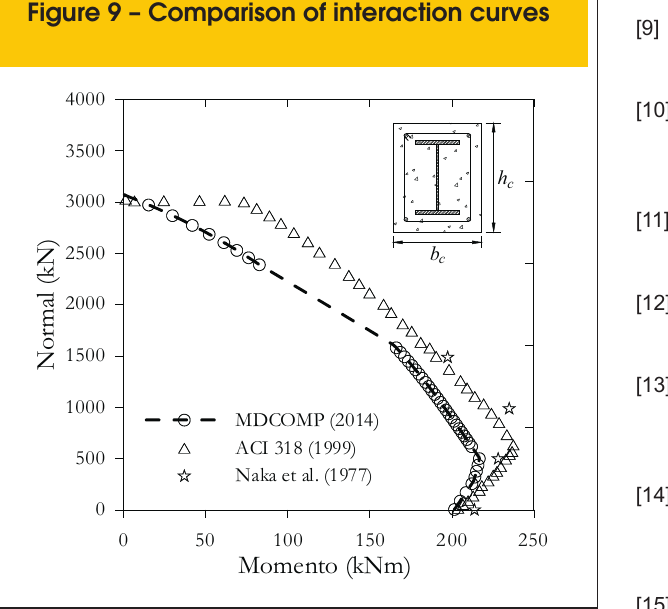
Figure 9 – Comparison of interaction